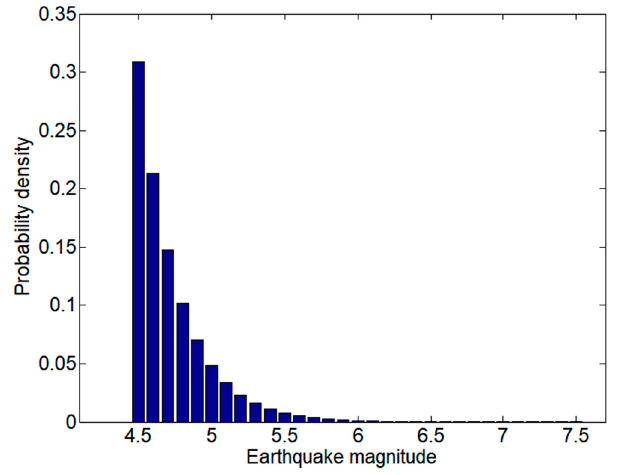
Figure 6. Discrete bounded probability density function of earthquake magnitude ranging from 4.5 to 7.5.